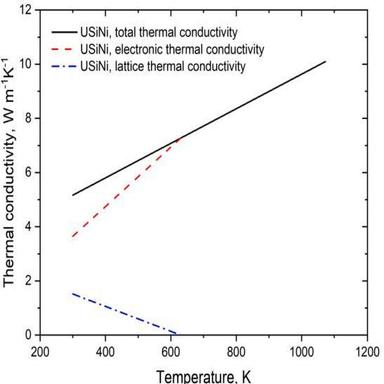
Total, electronic, and lattice thermal conductivity of annealed USiNi sample.